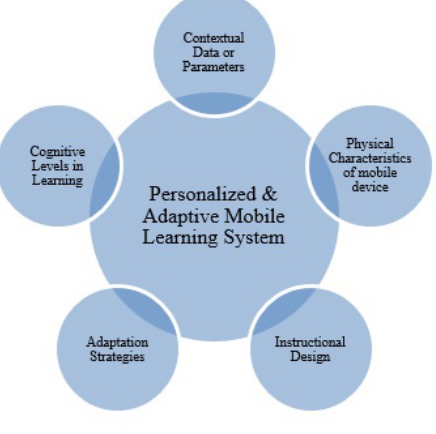
Figure 2. Problem-centred Radial Venn diagram